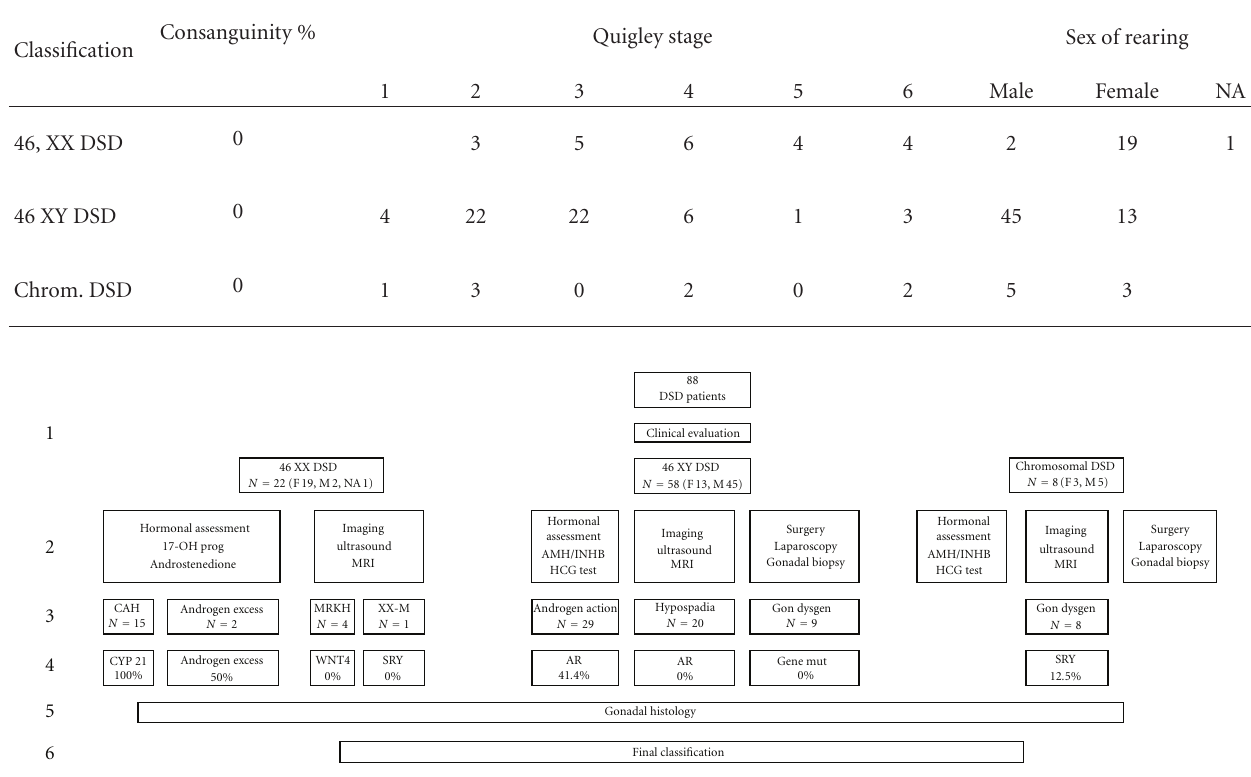
Figure 1: Stepwise diagnostic approach. An algorithm used with the aim of classifying the patients following the new classification system [8]. Row number 1 represents the clinical evaluation of the patients and classification following the primary root; number 2 the hormonal analysis and imaging followed by the secondary root classification (row 3). Row number 4 shows the percentage mutations that were found and number 5 the gonadal histology leading to the tertiary root and final classification of the patients. Explanation of abbreviations: MRKH: Mayer-Rokitansky-K¨ustner-Hauser Syndrome; XX-M; XX male.